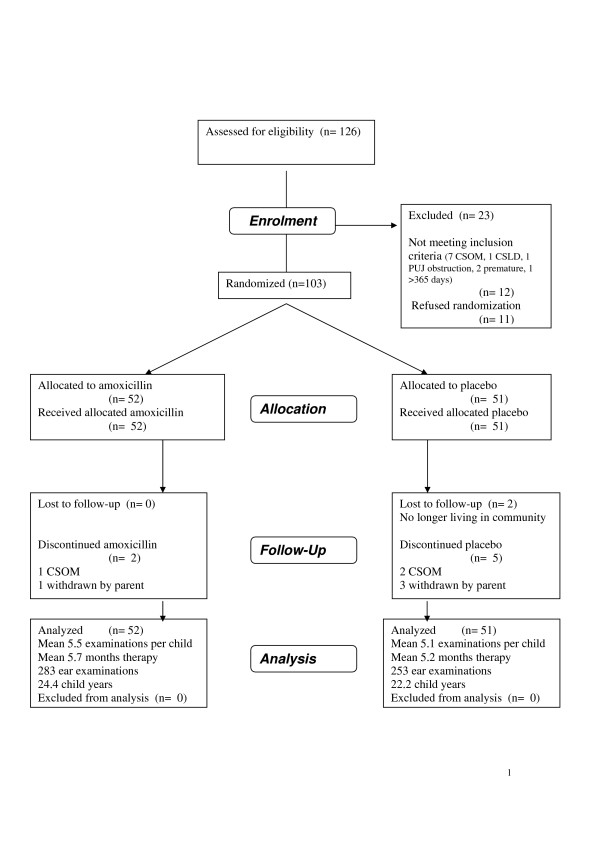
The Consort E-Flowchart. Participant Flow in the COMIT1 Trial.